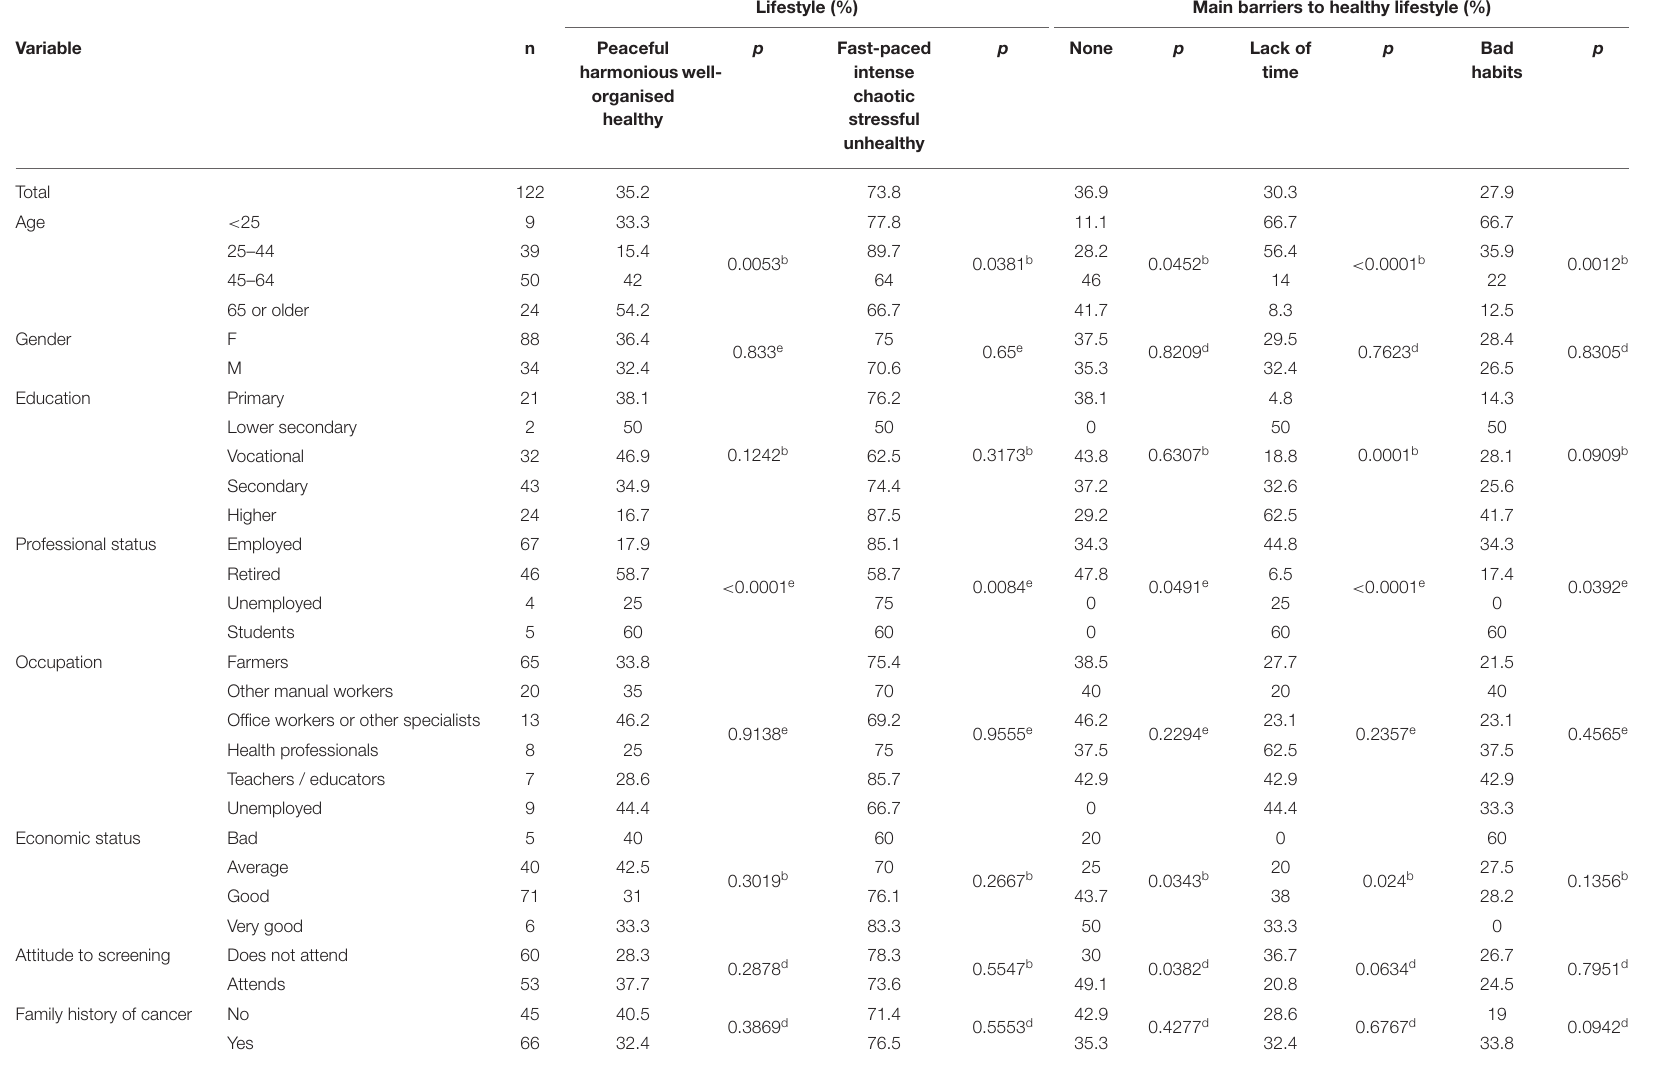
TABLE 6 | Lifestyle ( n =